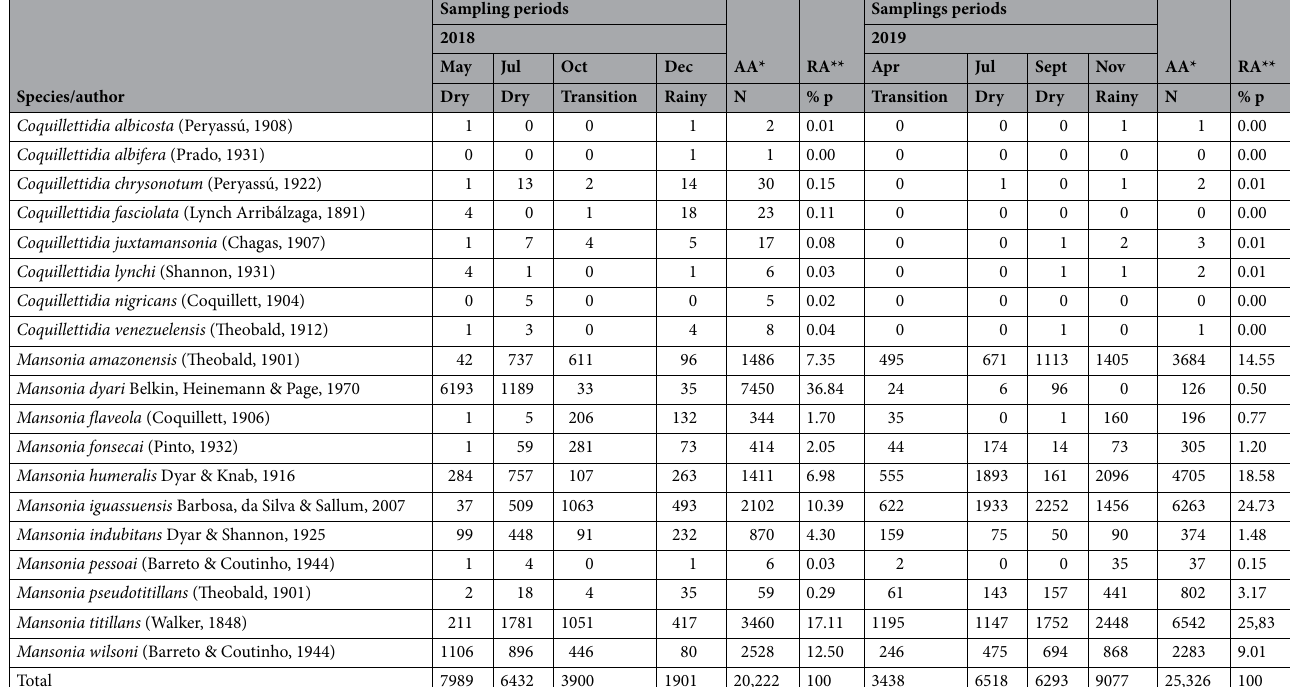
Table 3. Abundance of species of the tribe Mansoniini in areas surrounding the Jirau hydroelectric plant in Rondônia state, Brazil, in May, July, October, and December 2018 and April, July, September, and November 2019. * Absolute abundance. * * Relative